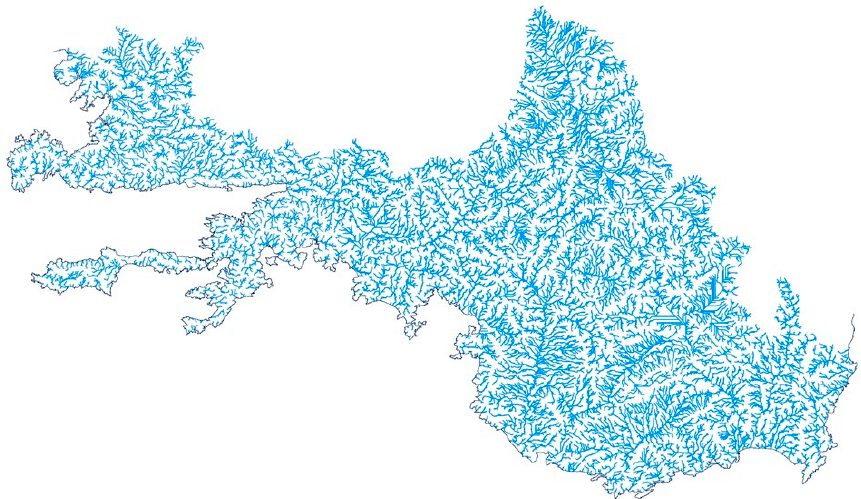
Figure 7. The drainage network derived according to the Mean value.